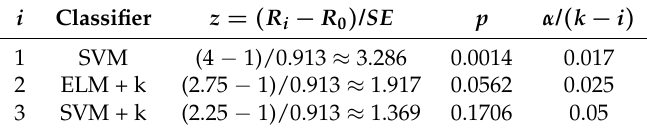
Table 11. Holm test of the gradual effectiveness evaluation on criterion C